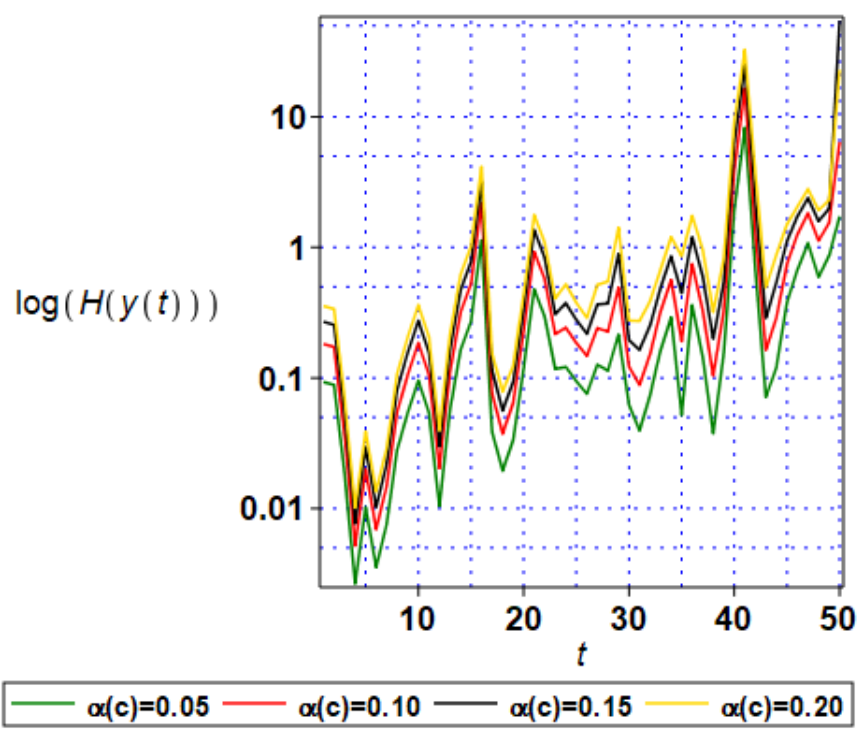
Figure 7. Shannon entropies time fluctuations for uniformly distributed structural damping.